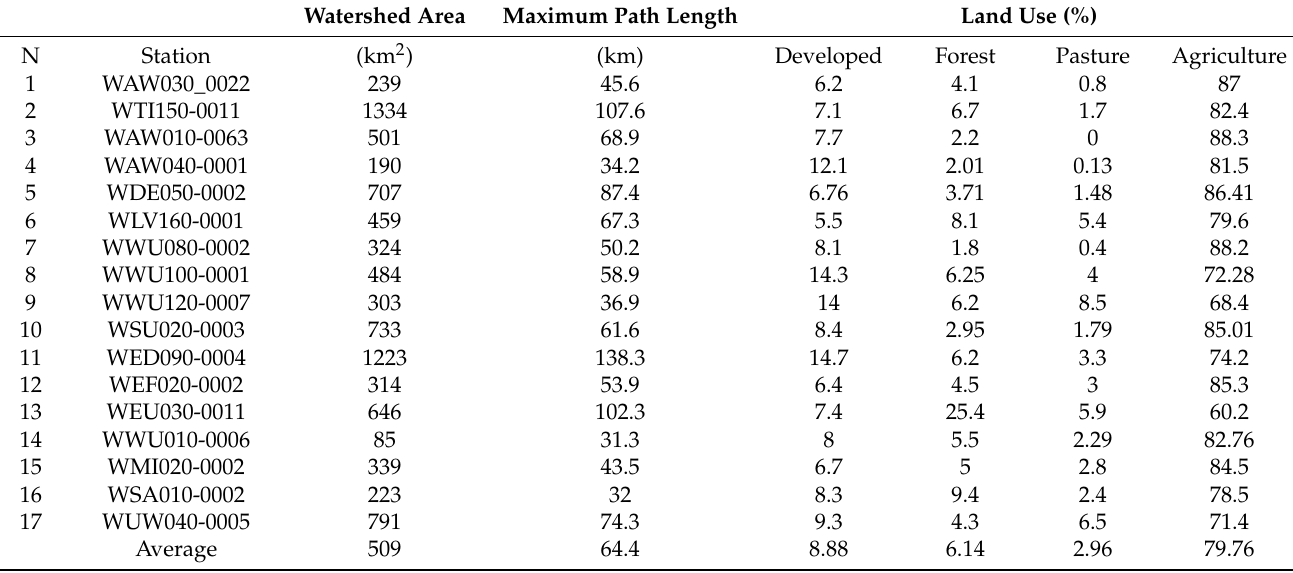
Table 1. Land use percentages [45] in 2001 for the study watersheds at the water quality stations. Watershed Area Maximum Path Length Land Use (%) (km 2 ) (km) Developed Forest Pasture Agriculture